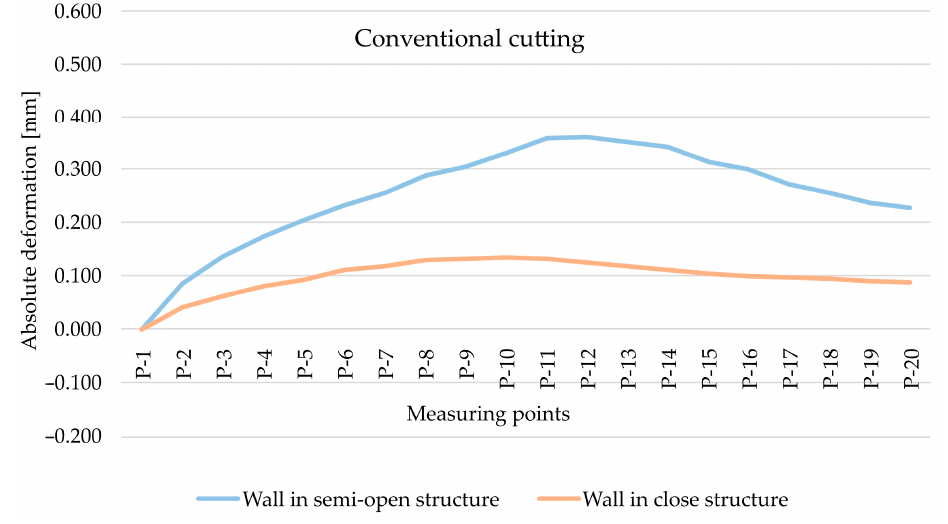
Figure 13. The comparison of absolute deformation for individual measurement points depending on the geometry of the thin-walled sample for conventional cutting and for the EN AW-6082 T651 aluminium alloy.